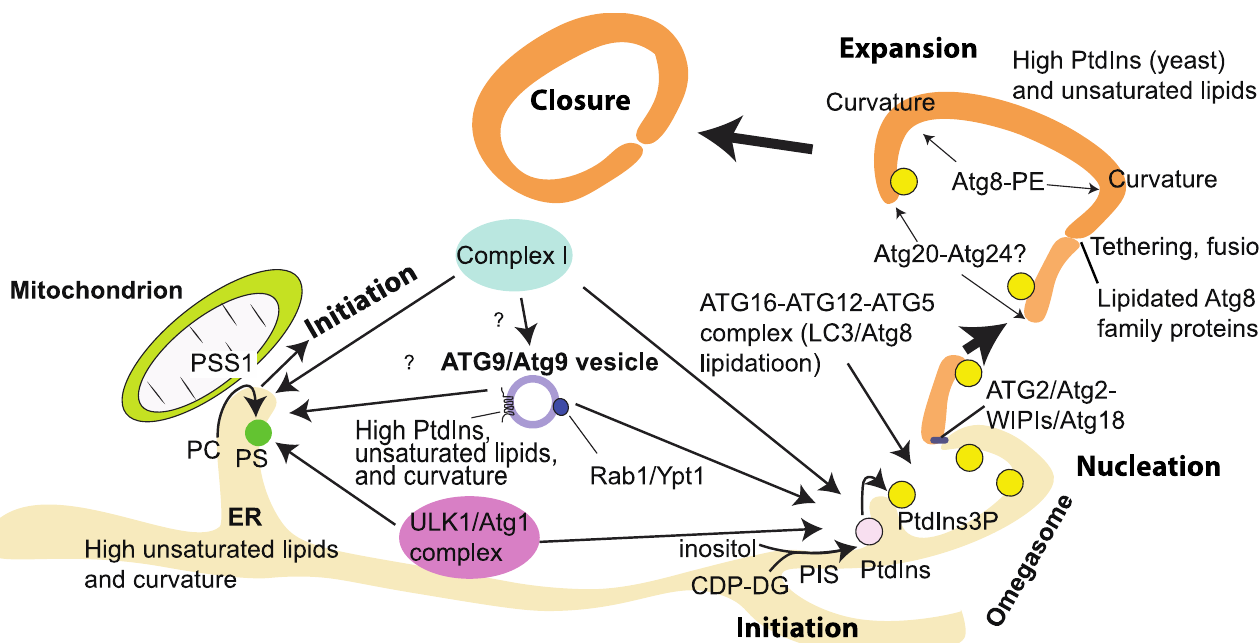
Figure 6. Summary of membrane/lipid environments that are targeted by autophagy-related proteins. During starvation, PtdIns is synthesized in the ER by PIS, which is targeted by the ULK1 complex and essential for the generation of the autophagosome. Complex I, the ATG16–ATG12–ATG5 complex, and the ATG2/Atg2–WIPI4/Atg18 complex prefer unsaturated (unpacked) and highly curved membranes for their activations. ER membranes and ATG9/Atg9 vesicles fulfil these conditions. During expansion, phagophores are tethered and fused, which is facilitated by Atg8 family proteins. Also, curvatures are generated at least by the lipidated yeast Atg8, and the yeast Atg20–Atg24 complex might detect and stabilize membrane curvatures at the edge of the expanding phagophore to support expansion. Along with this, upon starvation, PS synthesis occurs at the ER–mitochondria contact site by PSS1, which is targeted by the ULK1 and complex I. This may also lead to the initiation of autophagosome formation. Table 1. Summary of effects of lipid physicochemical parameters on the activities and membrane binding of autophagy- related proteins. The lipid physicochemical parameters of ATG9/Atg9 vesicles are also involved. Protein (Complex) Packing Curvature Electrostatics Reference PS concentration did not affect membrane binding Atg1 complex binding Binds more strongly of Atg1 and Atg13, [97,187] Not known PtdIns(3)P increased to membranes to smaller vesicles Atg1 binding to mem- branes